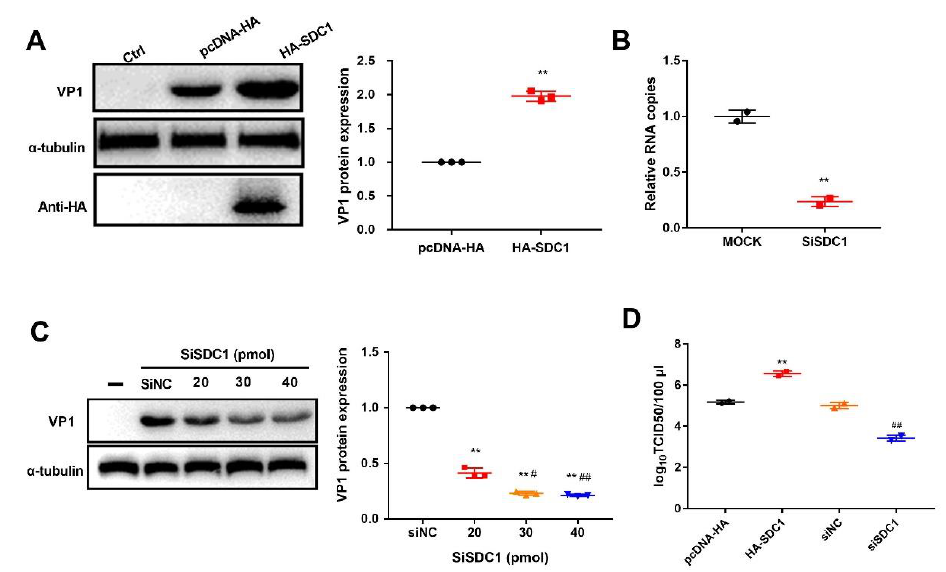
Figure 8. The e ff ect of syndecan-1 (SDC1) on PSV replication. ( A ) After 24 h transfection with pcDNA-HA empty or HA-SDC1, PK-15 cells were infected with PSV (MOI = 2), cells were lysed, and virus VP1 proteins were analyzed by Western blot. ( B ) The e ff ect of siRNA against SDC1 was determined by RT-qPCR. ( C ) PK-15 cells were untreated or transfected with siNC, 20 pmol, 30 pmol, or 40 pmol siSDC1. At indicated time after transfection, cells were infected with PSV and processed for Western blot. ( D ) Virus titers were determined by 50% tissue culture infective doses (TCID50) of samples prepared at 8 h post-infection from PK-15 cells infected with PSV after transfection with pcDNA-HA empty, HA-SDC1, siNC, or 30 pmol siSDC1. Two independent experiments were performed. The ** p < 0.01 compared with siNC or pcDNA-HA group. The # p < 0.05, ## p < 0.01 compared with 20 pmol group.